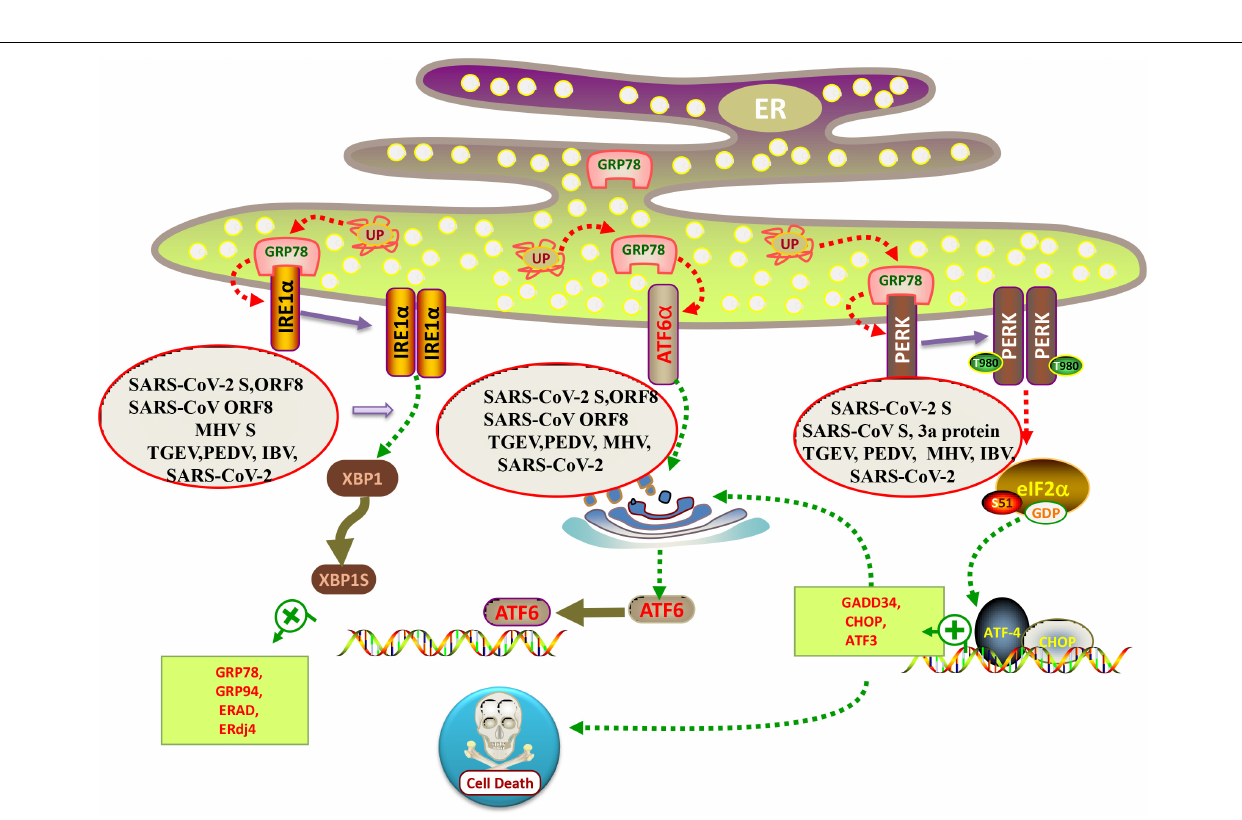
FIGURE 2 | Schematic diagram of coronavirus infection modulating the UPR arms. When misfolded proteins accumulate in the lumen of ER, chaperone binding immunoglobulin (BiP/GRP78) is separated from the lumen domains of the three ER sensors, allowing PERK and IRE1 to form a homodimer and activate the transport of ATF6 to the Golgi. All three branches of the UPR were induced in SARS-CoV-2, MHV, PEDV and TGEV infected cells. Individual over-expression of SARS-CoV and SARS-CoV-2 ORF8 protein is sufficient to induce the IRE1 and ATF6 pathway of UPR. While SARS-CoV-2 S protein activates all three branches of the UPR, SARS-CoV S protein only induces PERK